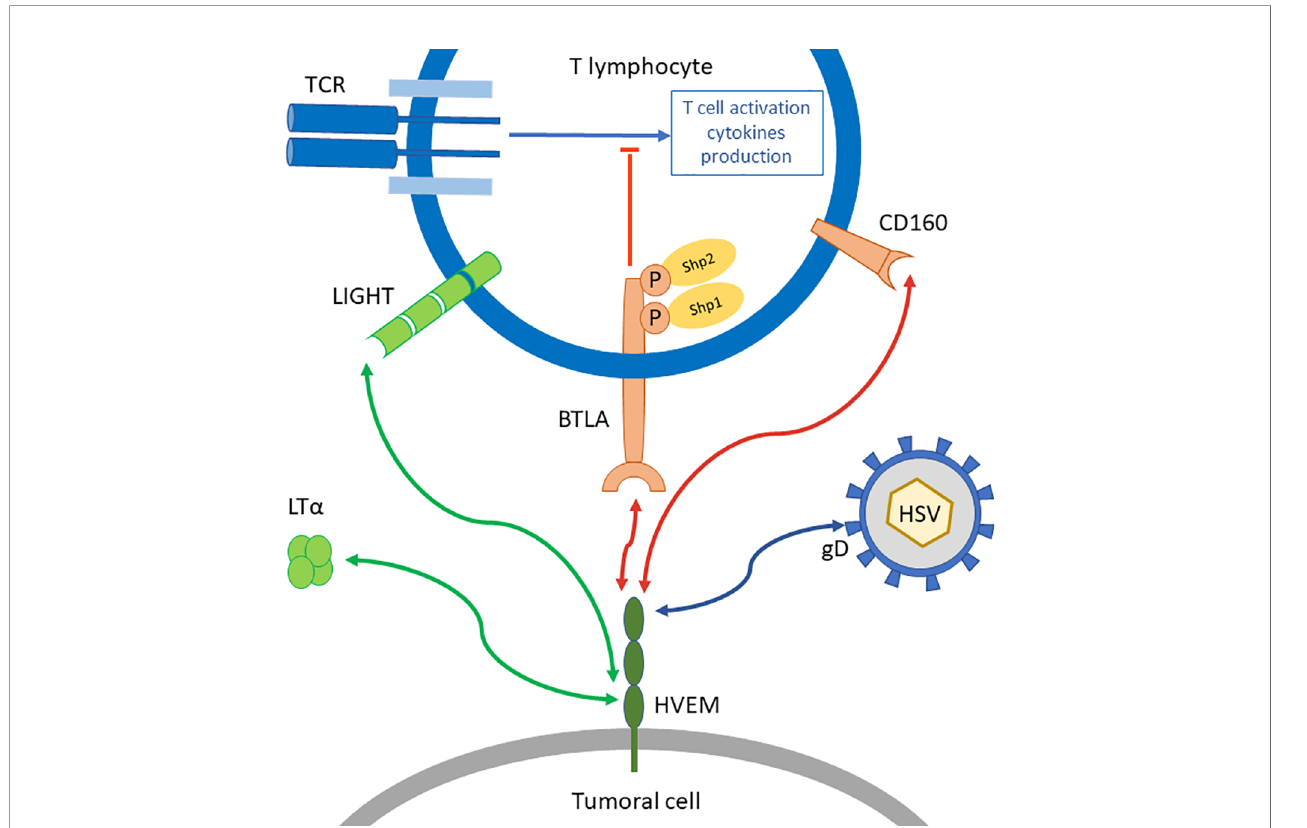
FIGURE 1 | BTLA/HVEM network. BTLA is a co-inhibitory receptor that represses TCR signal transduction in T lymphocytes through the recruitment of Shp1 and Shp2. Its ligand HVEM can also bind other molecules such as LIGHT or Lymphotoxin- a (LT a ) which triggers co-stimulatory signals (green arrows), or CD160 another co-inhibitory receptor (red arrows) on distinct binding sites. HVEM is also binding to glycoprotein D from Herpes Simplex Virus